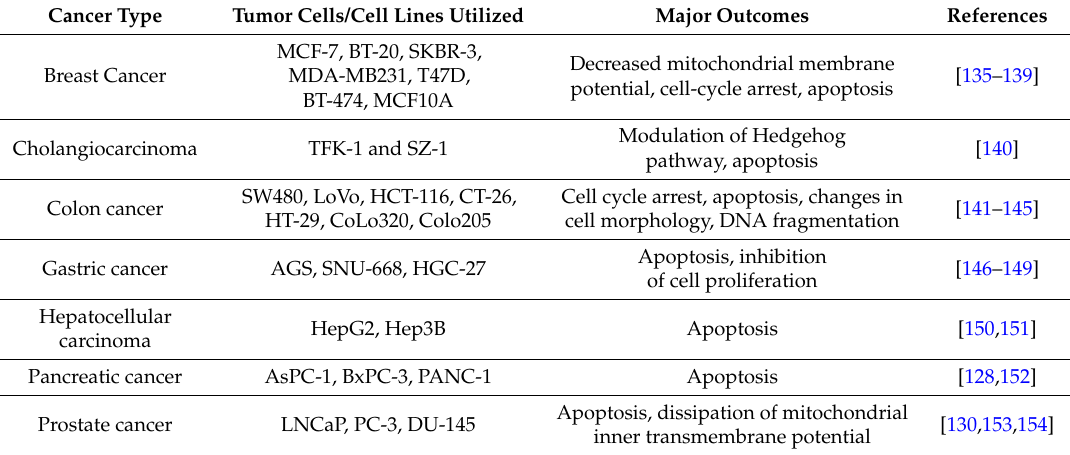
Table 3. Summary of the antitumorigenic effects of capsaicin in several cancer cells/cell